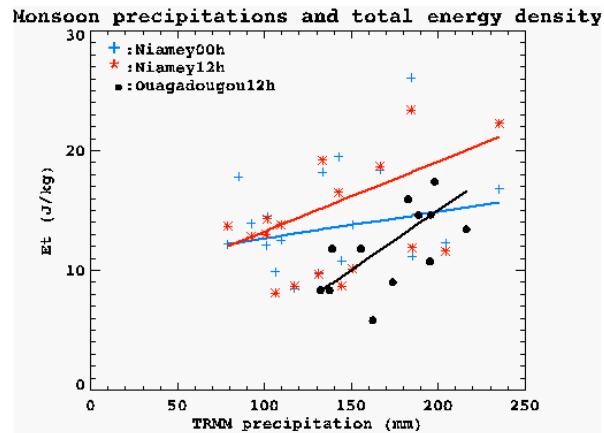
Fig. 7. Linear regression between TRMM monthly rain quantity and total energy density at heights between 19 and 23km during the WAM from 2001 to 2006 for Niamey at 00:00UT, Niamey at 12:00UT and Ouagadougou at